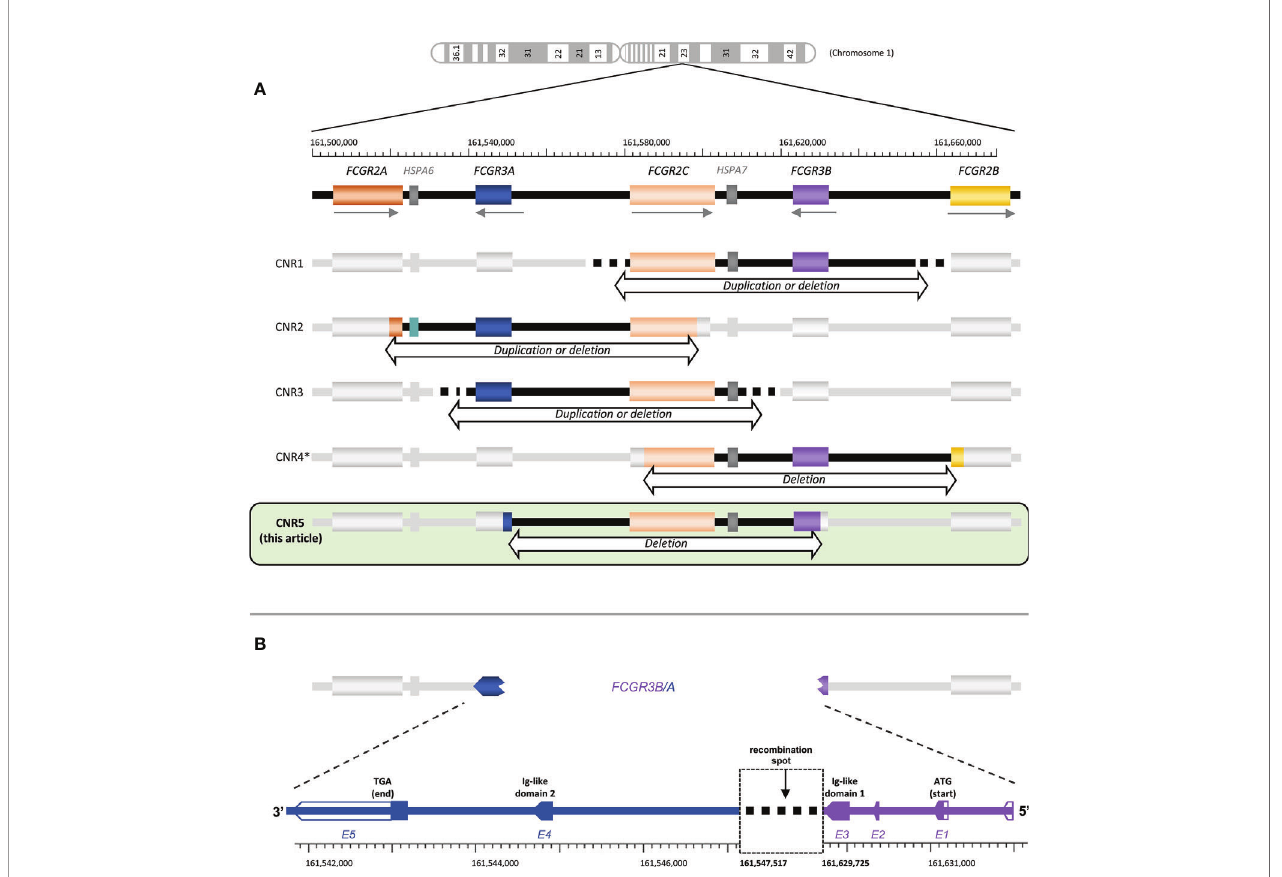
FIGURE 1 | FCGR locus structure and variation. (A) The structure of the FCGR locus and the approximate localization of all known FCGR CNR are depicted, including the one described here. (B) Schematic representation of the FCGR3B/A recombination. Empty arrows correspond to untranslated regions. Gene locations and nucleotide numbering are derived from the human genome build GCRh38. *CNR4 represented here is the one described in Nagelkerke et al. (3). Lassauniere et al. (4) also called CNR4 a different region, involving exclusively FCGR2C (i.e., it does not cover a region of ~82.5 Kbp, compatible with NAHR event of the repeat units in the FCGR locus). Because its presence in the genome has not been con fi rmed by other studies, we have not included it